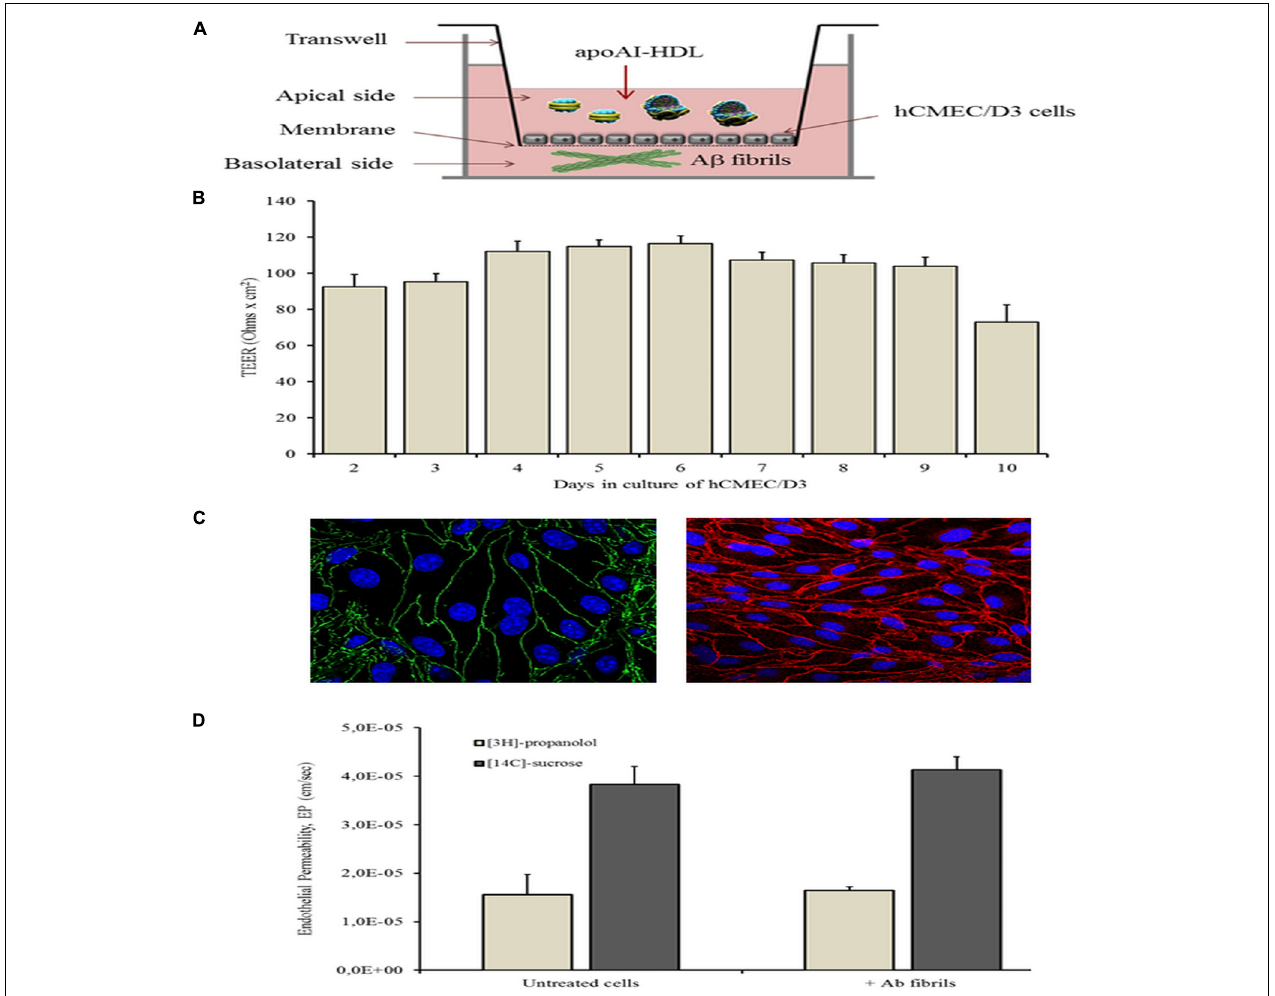
FIGURE 4 | In vitro BBB model. The in vitro BBB model, made in a transwell system by culturing hCMEC/D3 cells was characterized by monitoring the TEER values over time, by probing the formation of tight junctions and by measuring the para- and transcellular passage of radioactively labeled probes. (A) Graphical representation of BBB model. (B) TEER values monitored from 2 to 10 days in culture. (C) confocal microscopy visualization of tight and adherens junctions (blue, nuclei; green, ZO-1; and red, VE-cadherin). (D) endothelial permeability of [ 14 C]-sucrose, as probe for paracellular permeability, and [ 3 H]-propranolol, as probe for transcellular permeability, before and after incubation with A β fibrils in the basolateral compartment of the transwell system.